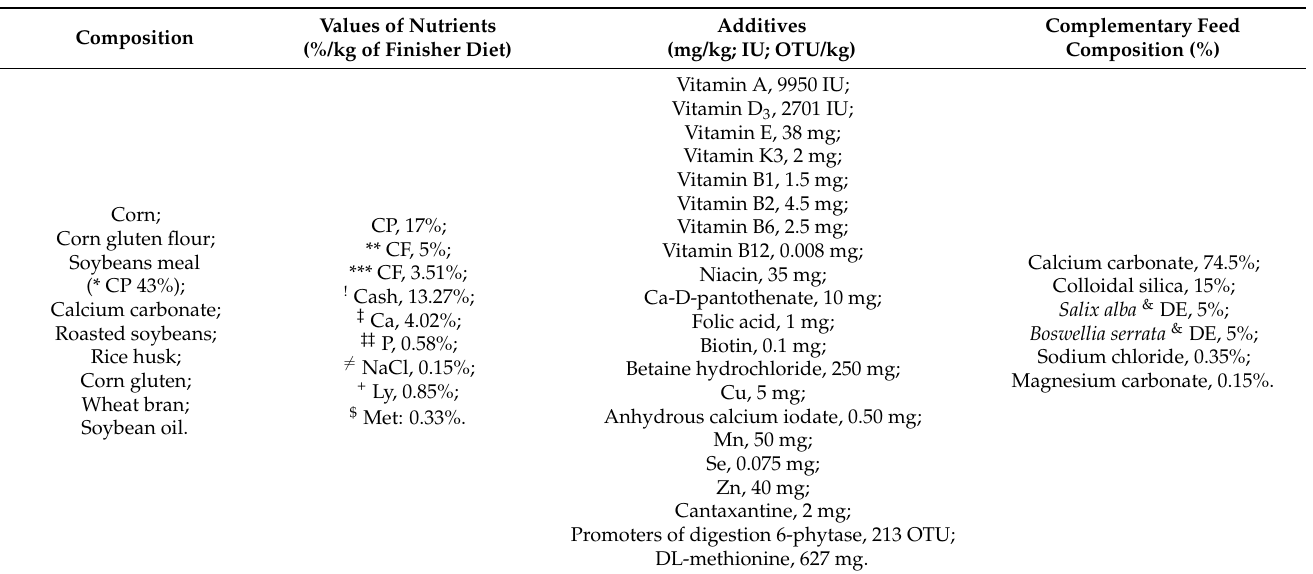
Table 1. Feed formulation of the commercial diet (Cargill s.r.l) based on the indications of the com- mercial tag and composition of the complementary feed. The table was obtained from Guerrini et al. (2022)